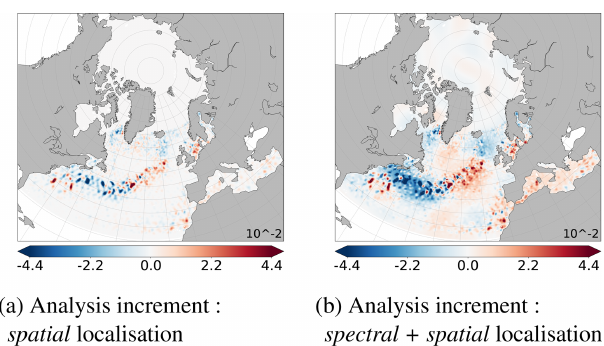
Figure 8. Same as Fig. 6a and c but keeping the full spectrum (no extraction of the large scales): (a) obtained after spatial localisa- tion only, following Eq. (6); (b) obtained after multiscale analysis (spectral + spatial localisation) following Sect. 4.1.2 (to be com- pared with Fig.